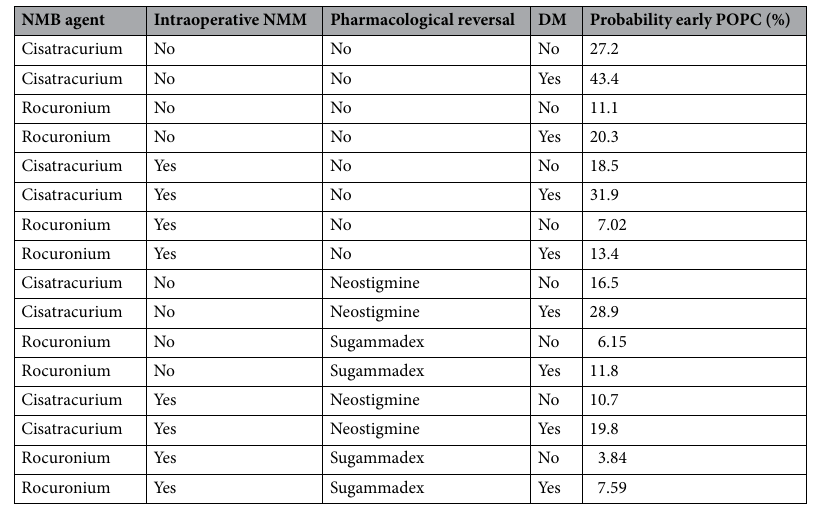
Table 4. Probability of early postoperative pulmonary complications (hypoxemia and airway obstruction) according to diabetes mellitus, neuromuscular blockade, neuromuscular monitoring and reversal (logistic regression model). According to the previous model, the table shows the incidences of residual neuromuscular blockade depending on the use of the neuromuscular blocking drug, the neuromuscular monitoring, and the reversal drug. NMB Neuromuscular blockade, NMM neuromuscular monitoring, RNMB residual neuromuscular blockade.